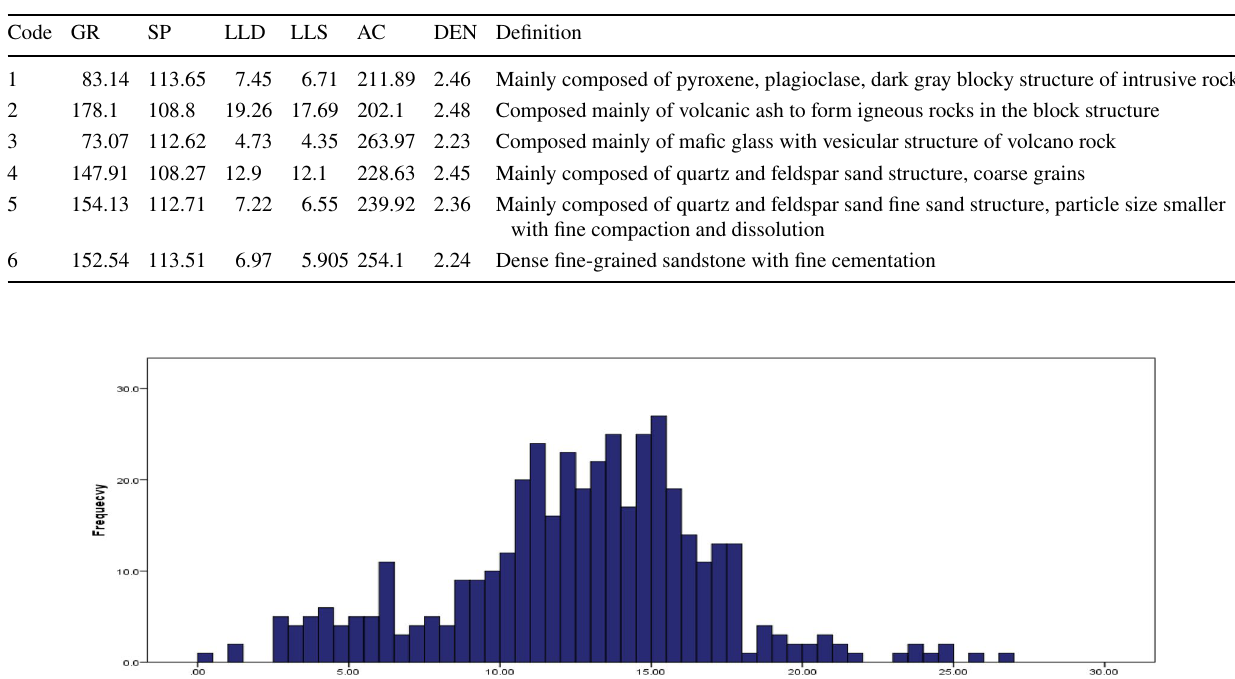
Table 1 The cluster center and the definition of the electrofacies